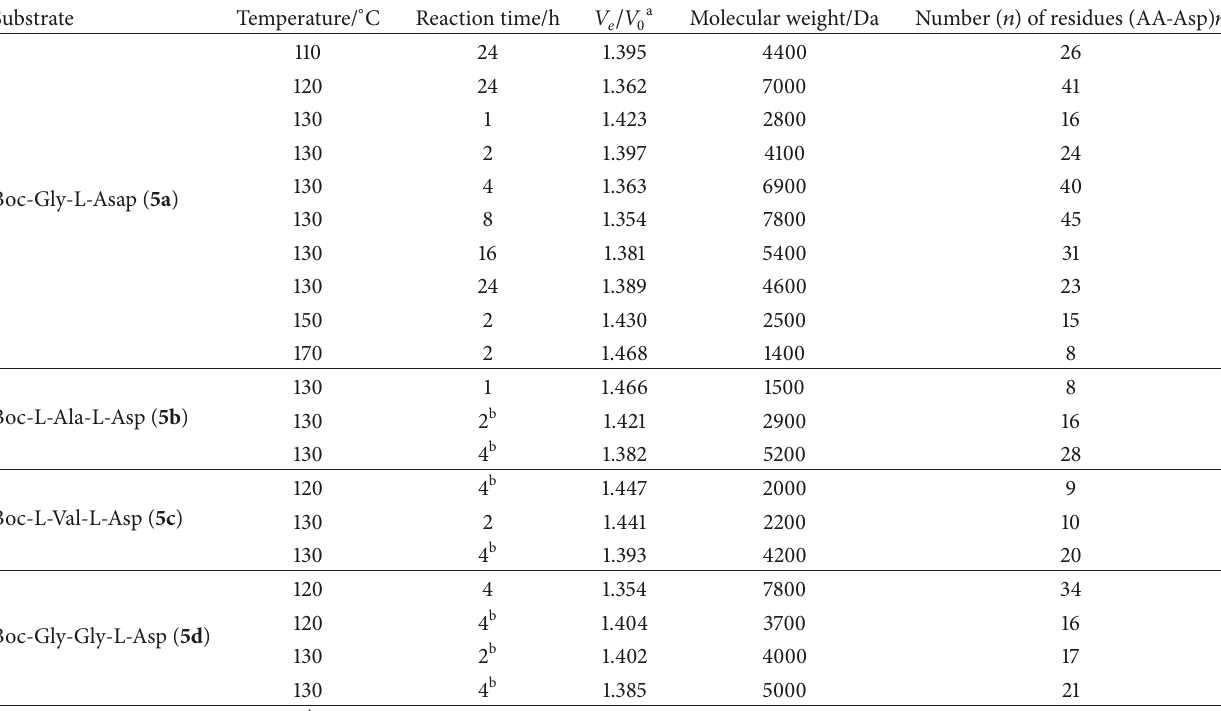
Table 2: Estimated molecular weight of the higher molecular weight fraction.